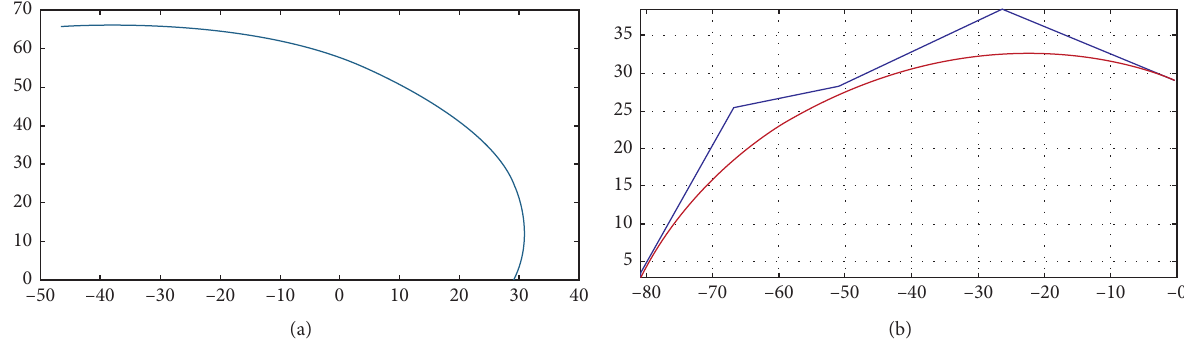
Figure 4: Blade profiles drawn by MATLAB software. (a) Logarithmic spiral method. (b) B-spline curve method.